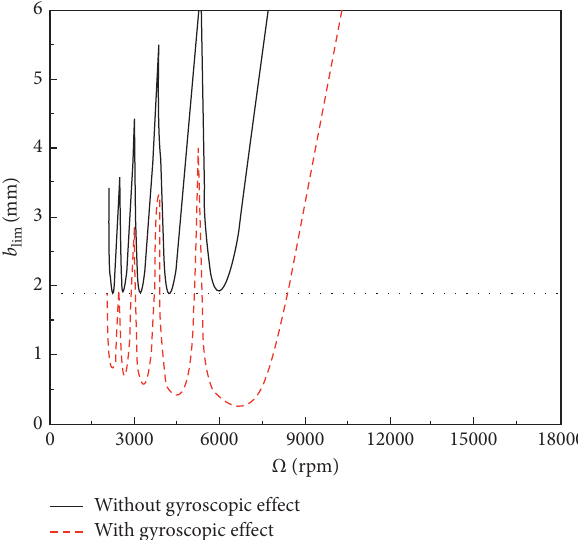
Figure 7: Stability lobes with and without the consideration of gyroscopic/rotating effect.